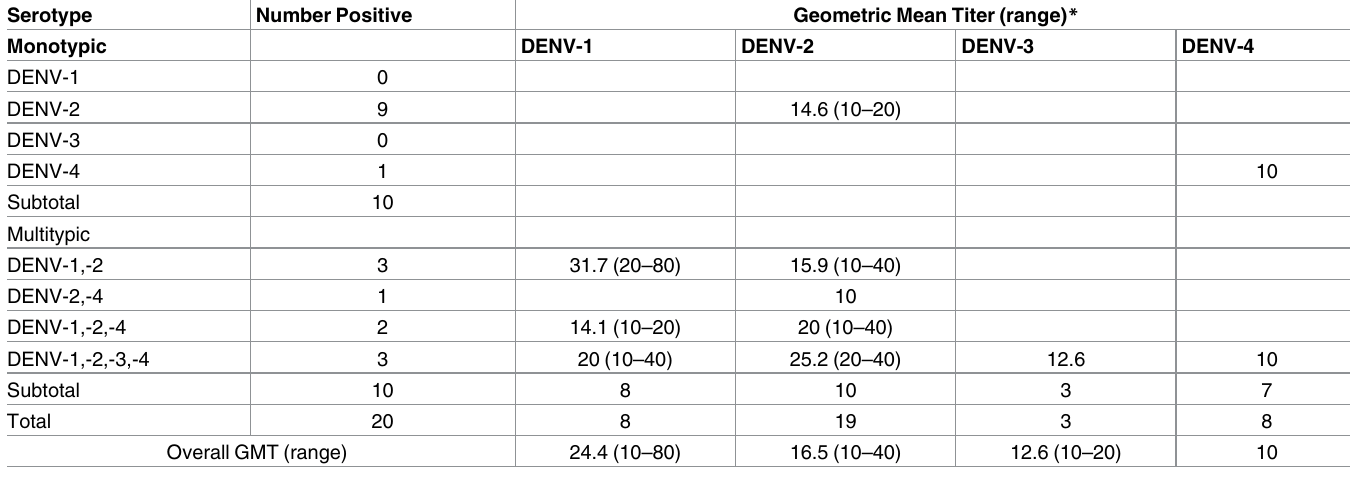
Table 5. Dengue neutralizing antibody responses, West